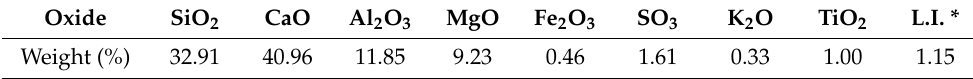
Table 1. Chemical composition of blast furnace slag.